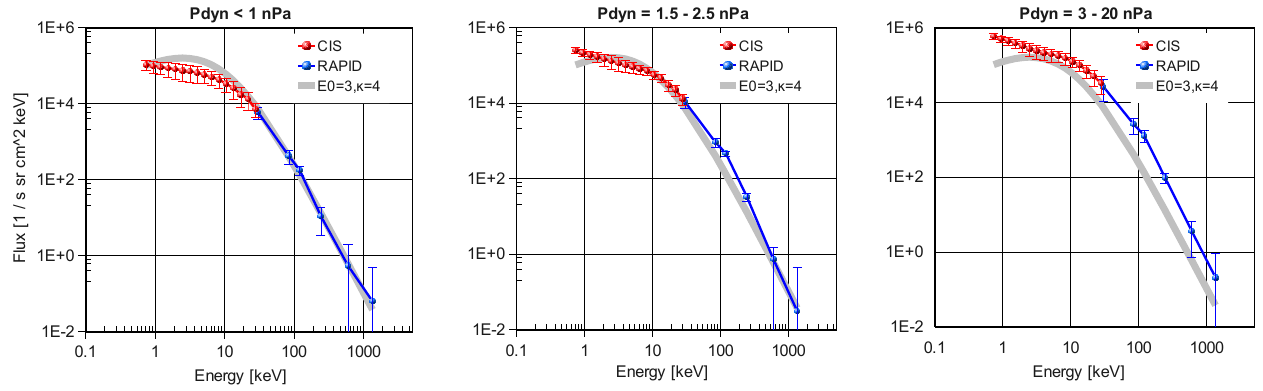
Fig. 6. Average proton spectrum for low (left panel), intermediate (center panel) and high (right panel) solar wind dynamic pressure. As for the other figures, gray curves represent a visual fit to the high energy part of the Pdyn=0–1nPa spectrum. The most notable response is a change towards higher characteristic energies for higher solar wind